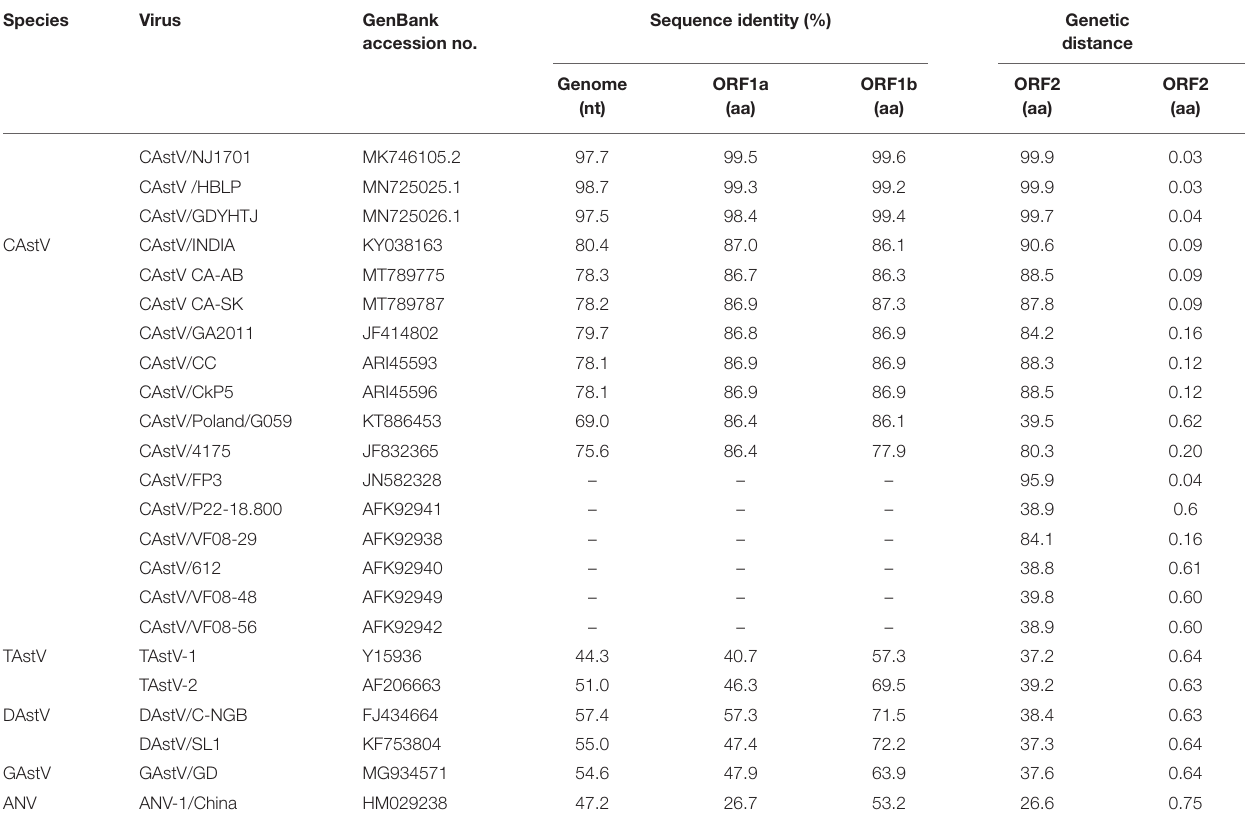
TABLE 1 | Comparisons of nucleotide and amino acid sequences of CAstV/CZ1801 with selected representative astroviruses.